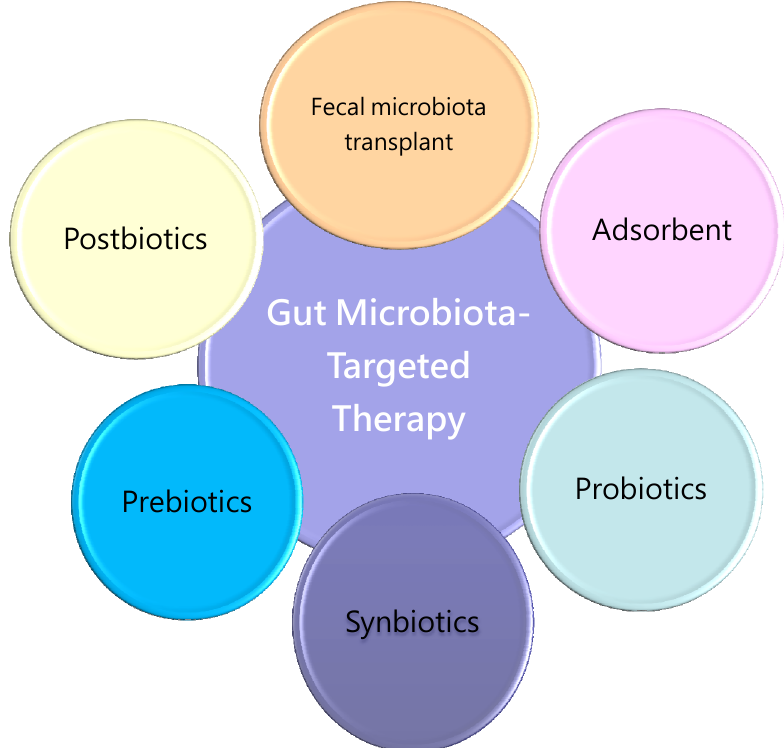
Figure 2. Schema outlining the potential gut microbiota-targeted therapies as a reprogramming strategy to prevent cardiovascular disease of developmental